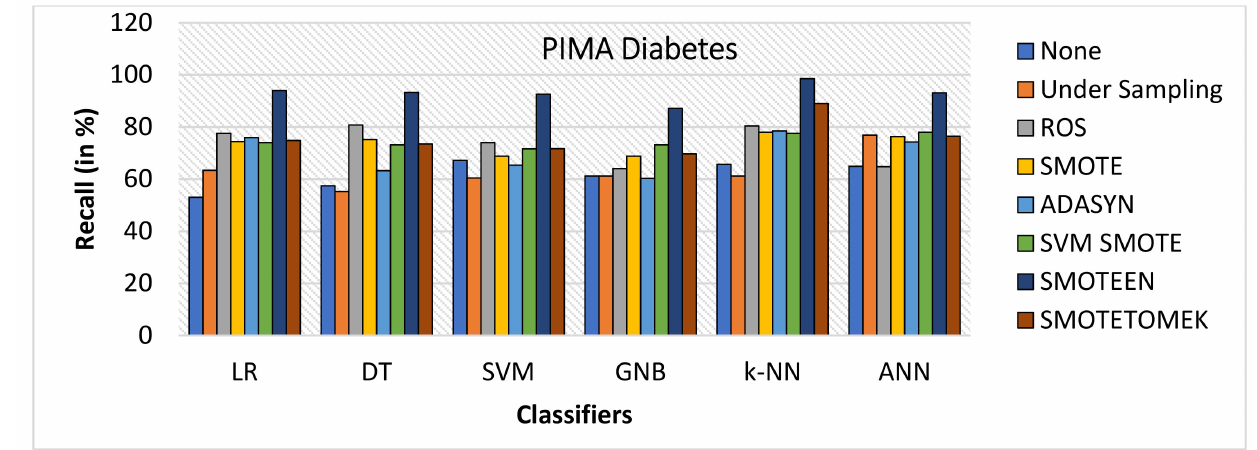
Figure 24. Recall for diabetes dataset of balancing algorithms over six classifiers.